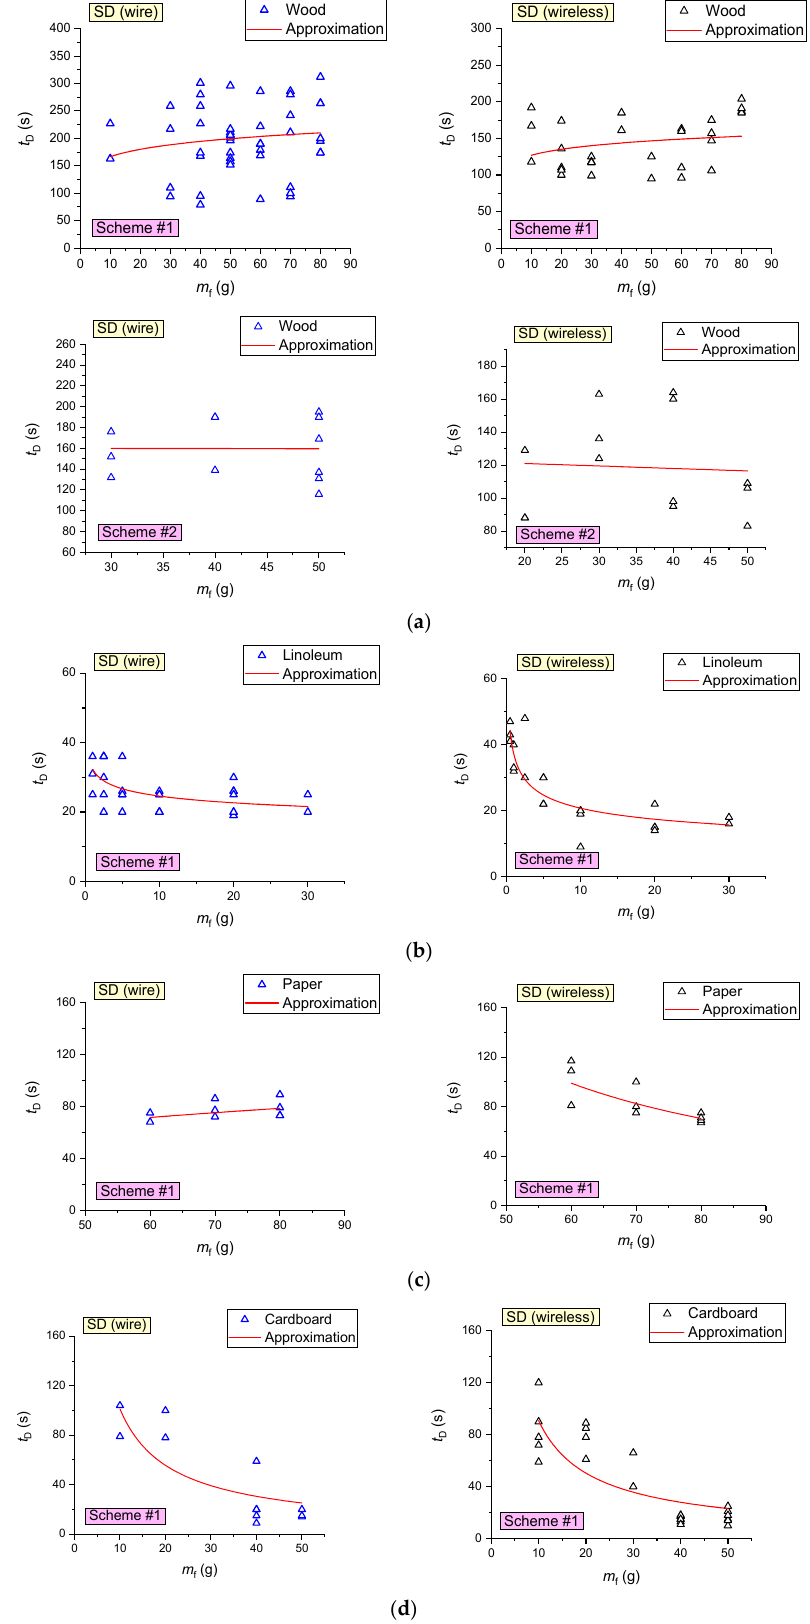
Figure 11. Delay times of SD activation versus the sample mass during the combustion of wood ( a ), linoleum ( b ), paper ( c ) and cardboard ( d ). Figure 12 presents the curves of FD activation delay times versus the mass of the sample (material to be burned) during the combustion of several types of model fires. It was established that FD activation times increase nonlinearly with the growth of the fuel’s initial mass. This result is attributed to the longer flame application with an increase in the sample mass. Additional experiments were conducted to confirm this conclusion, in which FD was turned on after the sustained flame growth of the model fire. The experiments revealed that the FD activation times during the stable combustion of materials (after flame application) did not depend on the mass of the fuel sample and varied in the range of 5–10 s. 0 10 20 30 40 50 60 70 80 90010 20304050 60 Scheme #1 t D ( s )